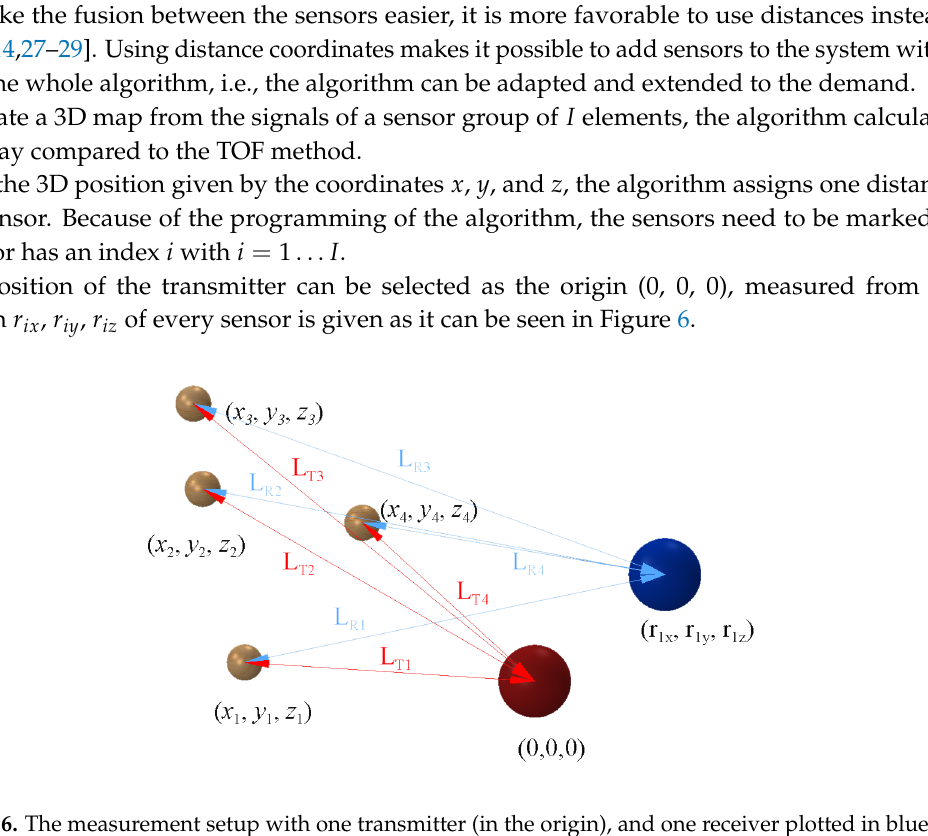
Figure 6. The measurement setup with one transmitter (in the origin), and one receiver plotted in blue (at position ( r 1 x , r 1 y , r 1 z